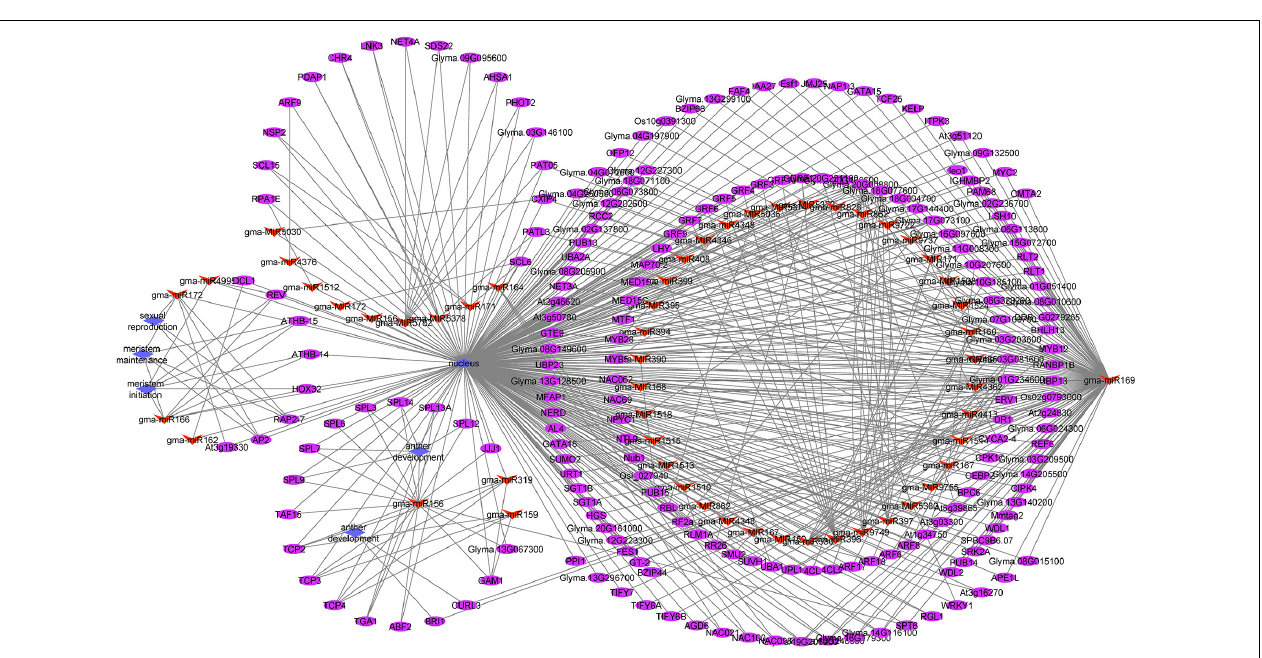
FIGURE 5 | The regulatory network comprising GO terms, microRNAs (miRNAs), and target genes in JLCMS9A and JLCMS9B. Diamonds, ellipses, and arrowheads represent the GO terms, target genes, and miRNAs,